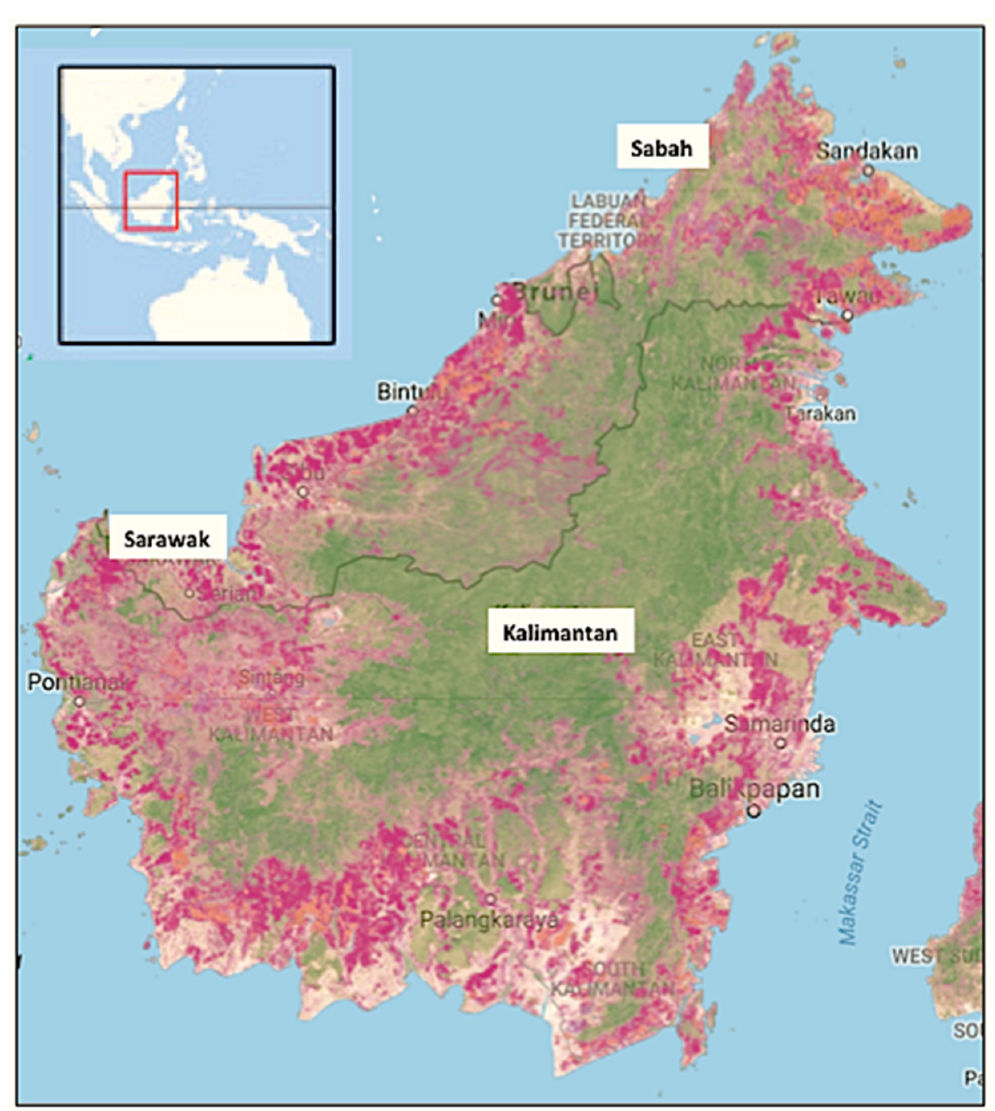
Figure 1. The island of Borneo, showing the Malaysian states of Sabah and Sarawak, and the Indonesian state of Kalimantan. Areas in pink have had high rates of native-forest loss (2000–2015), areas in red are oil palm or wood-pulp plantations (2015), and areas in green have high aboveground biomass of native trees (image and data from Global Forest Watch).